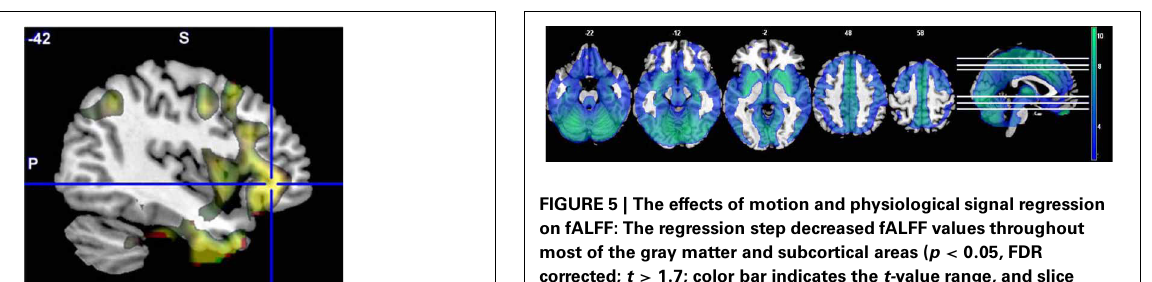
Maximal voxels are shown first, with secondary maxima in the same cluster shown in italics. Voxel p = FDR corrected p-value. *Indicates a cluster which was matched in the regressed ALFF analysis.